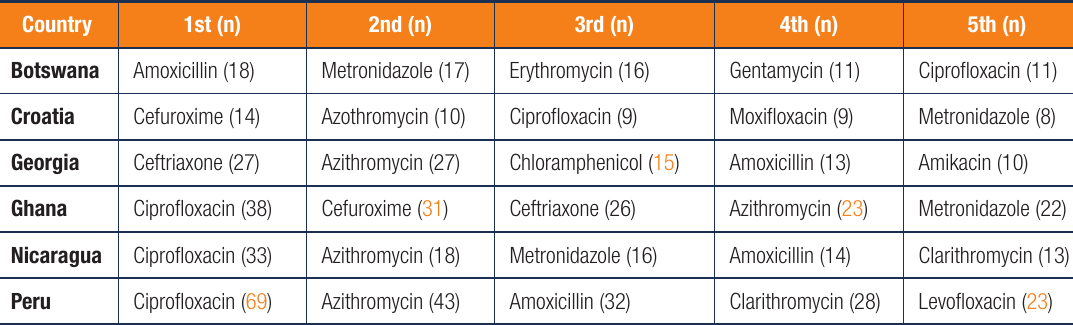
FIGURE A9.3. Top Five Active Ingredients According to Number of Brand